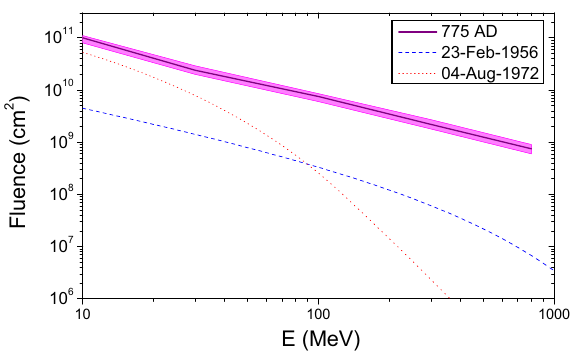
Fig. 25 Even-integrated SEP fluence spectra for the 775 AD event (Mekhaldi et al. 2015), the hardest known and the greatest soft-spectrum SEP events of 23-Feb-1956 and 04-Aug-1972, respectively (Tylka and Dietrich